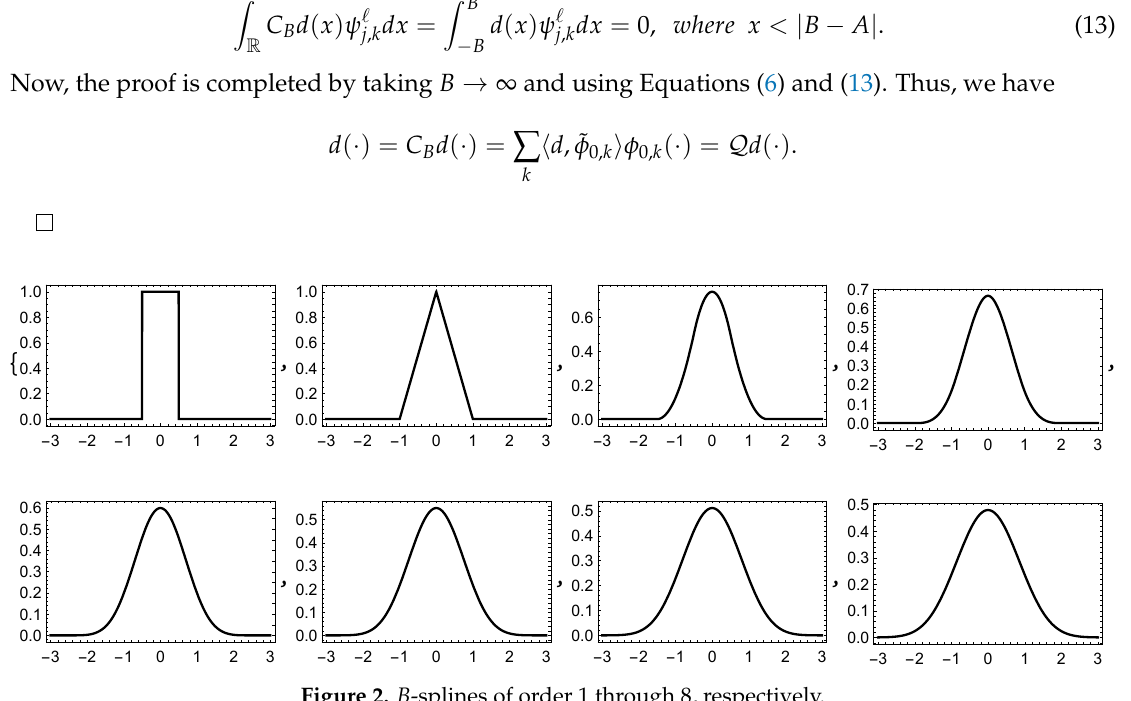
Figure 2. B -splines of order 1 through 8, respectively.